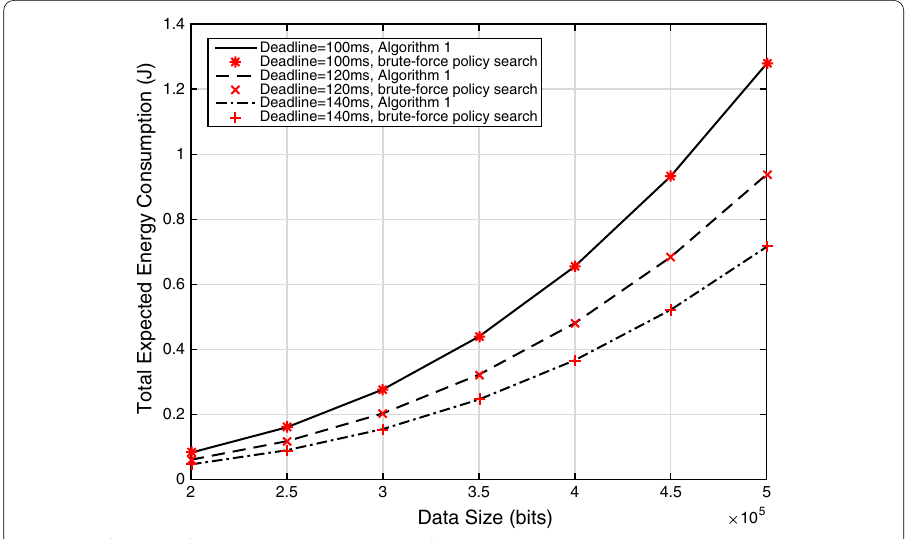
Fig. 2 Total expected energy consumption versus data